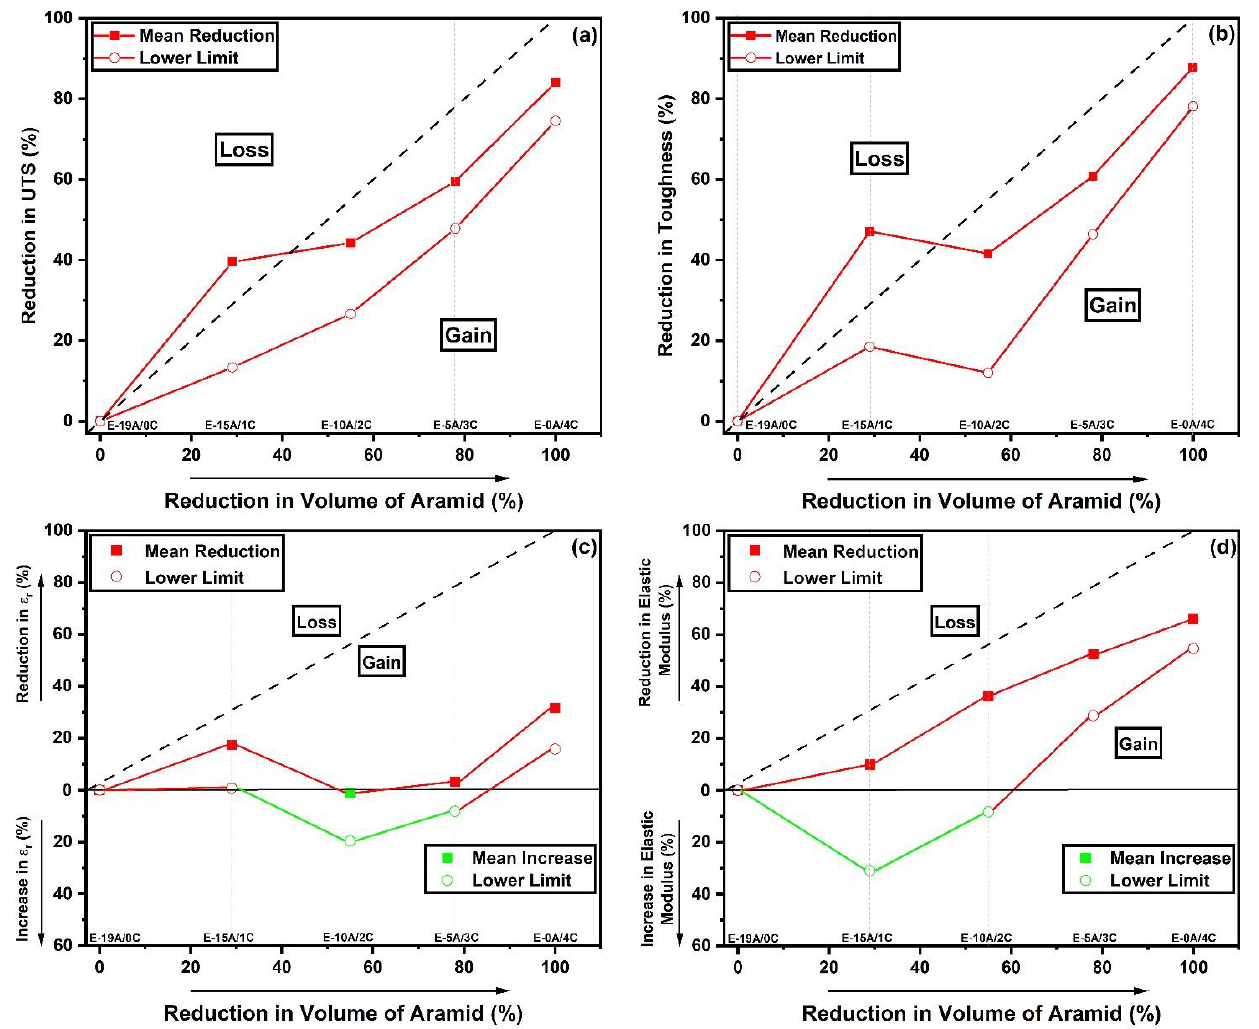
Figure 7. Reduction Maps for tensile properties of hybrid aramid/curaua composites: ( a ) UTS; ( b ) toughness; ( c ) deformation at rupture (ε r ); and ( d ) elastic modulus.